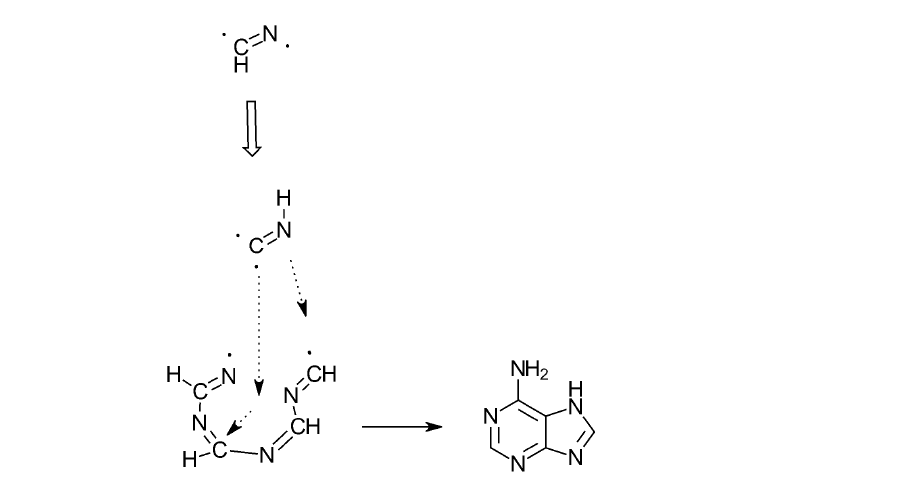
Scheme 4. A carbon atom from the fifth hydrogen cyanide (HCN) unit in the grip of the already formed